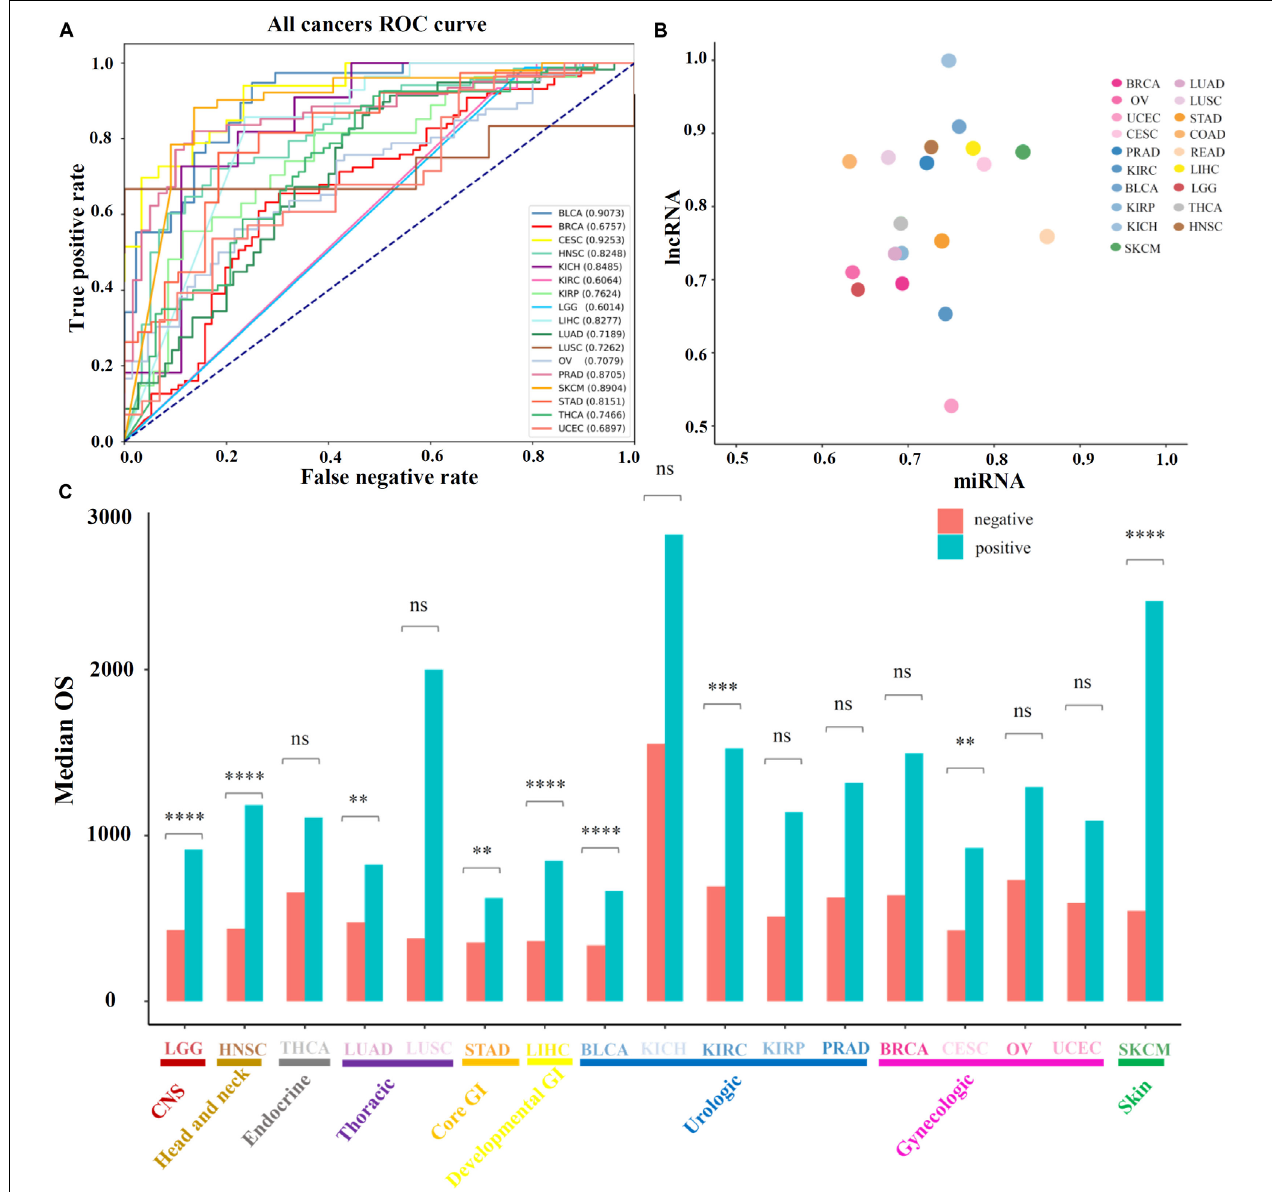
FIGURE 2 | Prediction performance of prognosis-related ncRNA markers. (A) The ROC curves of 19 solid tumors with prognosis-related ncRNA markers. (B) The AUC values of 19 cancer types, in which the X-axis represents the AUC values based on prognosis-related miRNAs and Y-axis represents the AUC values based on prognosis-related lncRNAs. (C) The median OS values and statistical significance of high-OS and low-OS samples for all 19 cancer types. Here, the P -values of the log-rank test in survival analysis were